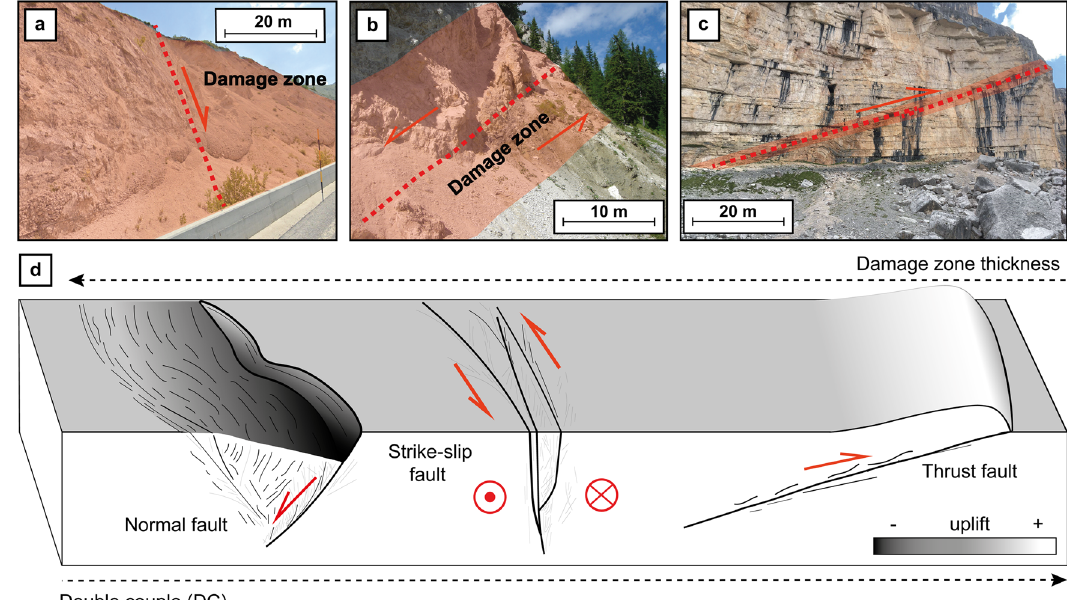
Fig. 8 The width of the cataclastic band and the sharpness of faults tend to decrease moving from normal faults (NF), strike-slip (SS), to thrust faults (TF). a , b , c : three examples from the Mesozoic carbonate rocks of the central Apennines ( a ) and the Dolomites in the eastern Alps ( b , c ) in central and northern Italy. d : Thrusts are generally associated with sharper, continuous faults with respect to strike-slip and normal faults, rather characterized by multiple and anastomosed faults andgenerating widercataclastic damagezones.Thisstructuralvariationcould explainwhythecoseismicslip alongthrust faults showsinaveragehigherdoublecouple. COMMUNICATIONS EARTH & ENVIRONMENT|